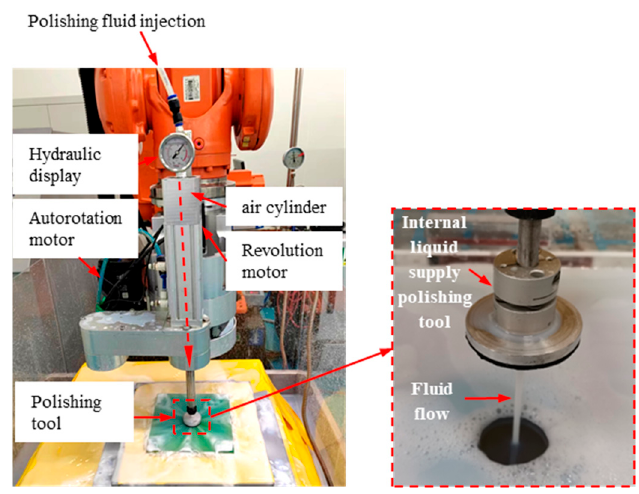
Figure 5. Center liquid supply small tool polishing device.